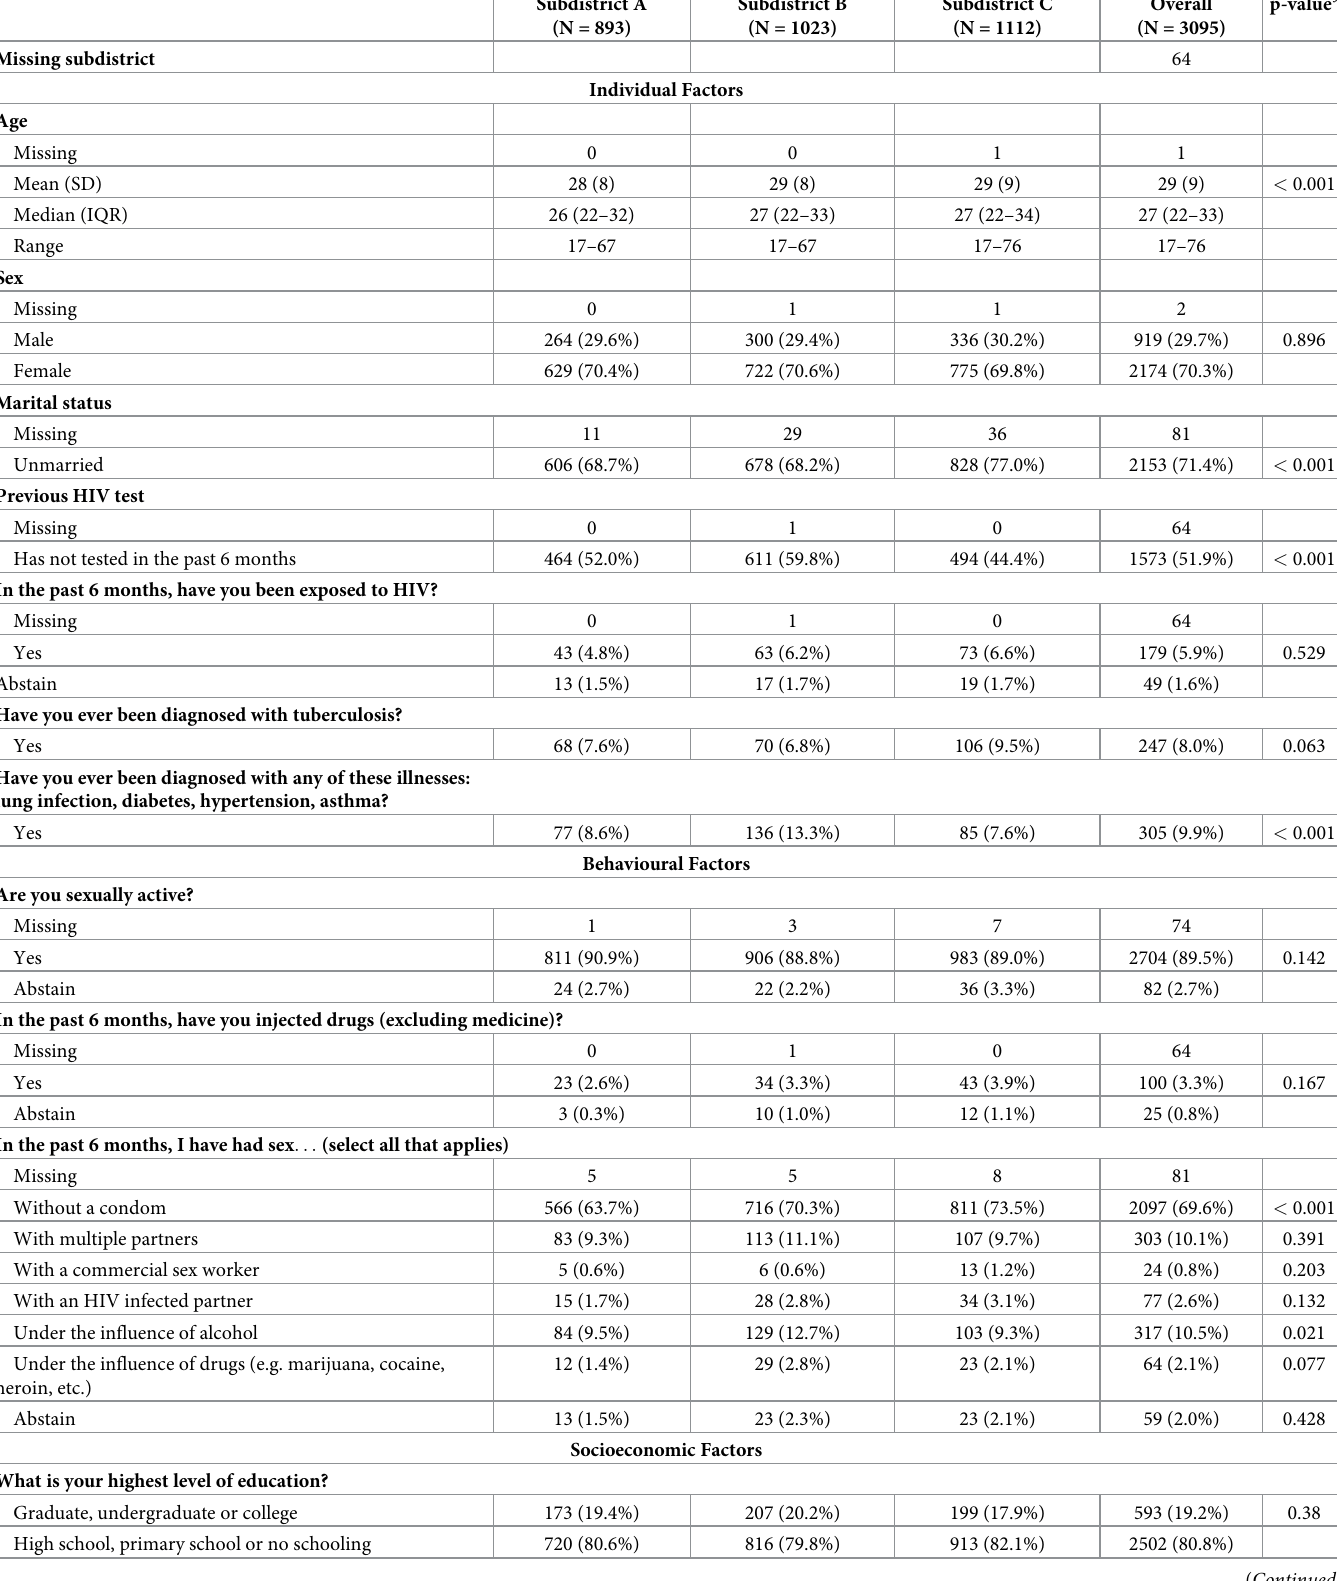
Table 1. Baseline characteristics of participants in subdistricts of Cape